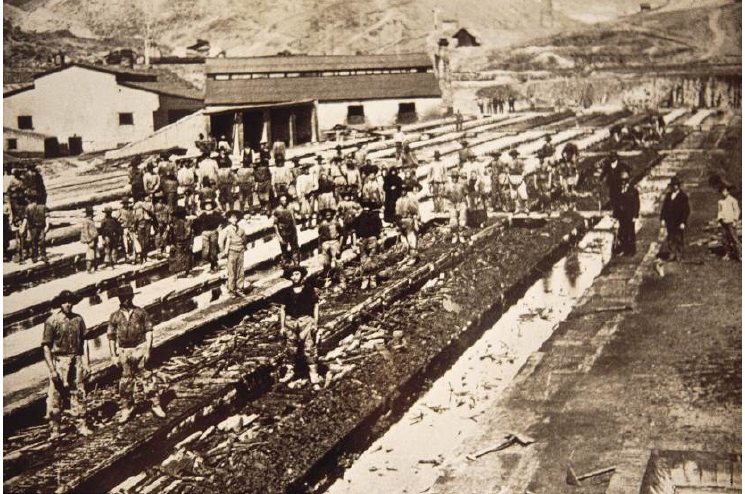
Figure 5. Channel systems for copper precipitation from acidic leachates